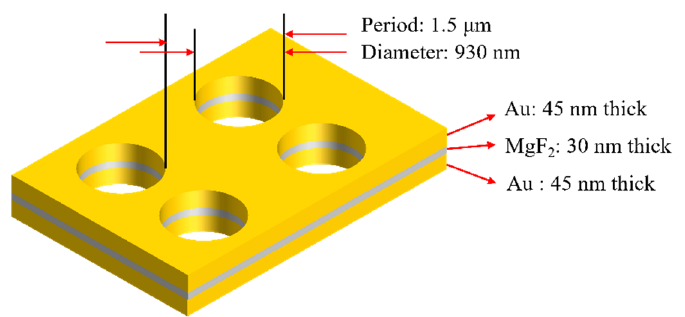
Figure 1. The diagram of theoretical